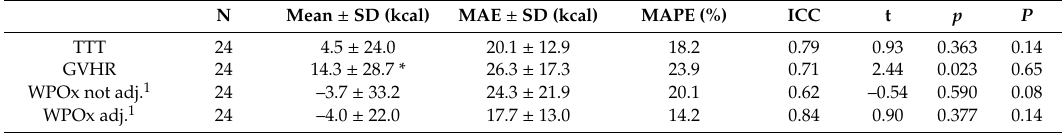
Table 3. Descriptive examination of the di ff erences between the measured EE (CM3B) and the estimated EE of the investigated fitness trackers. Arithmetic mean of estimated EE ± standard deviation (Mean ± SD); mean absolute error ± standard deviation (MAE ± SD); mean absolute percentage error (MAPE); intraclass correlation coe ffi cient (ICC); test statistic (t); probability value ( p ); statistical power ( P ). N Mean ± SD (kcal) MAE ± SD (kcal) MAPE